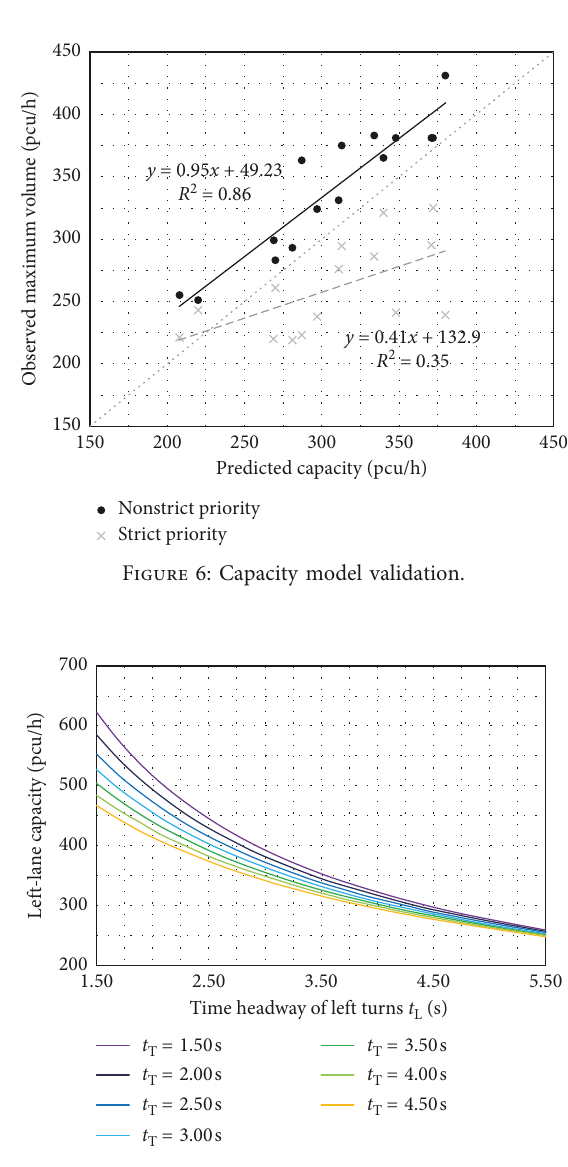
Figure 7: Sensitivity of left-lane capacity to time headway of left turns and crossing through.